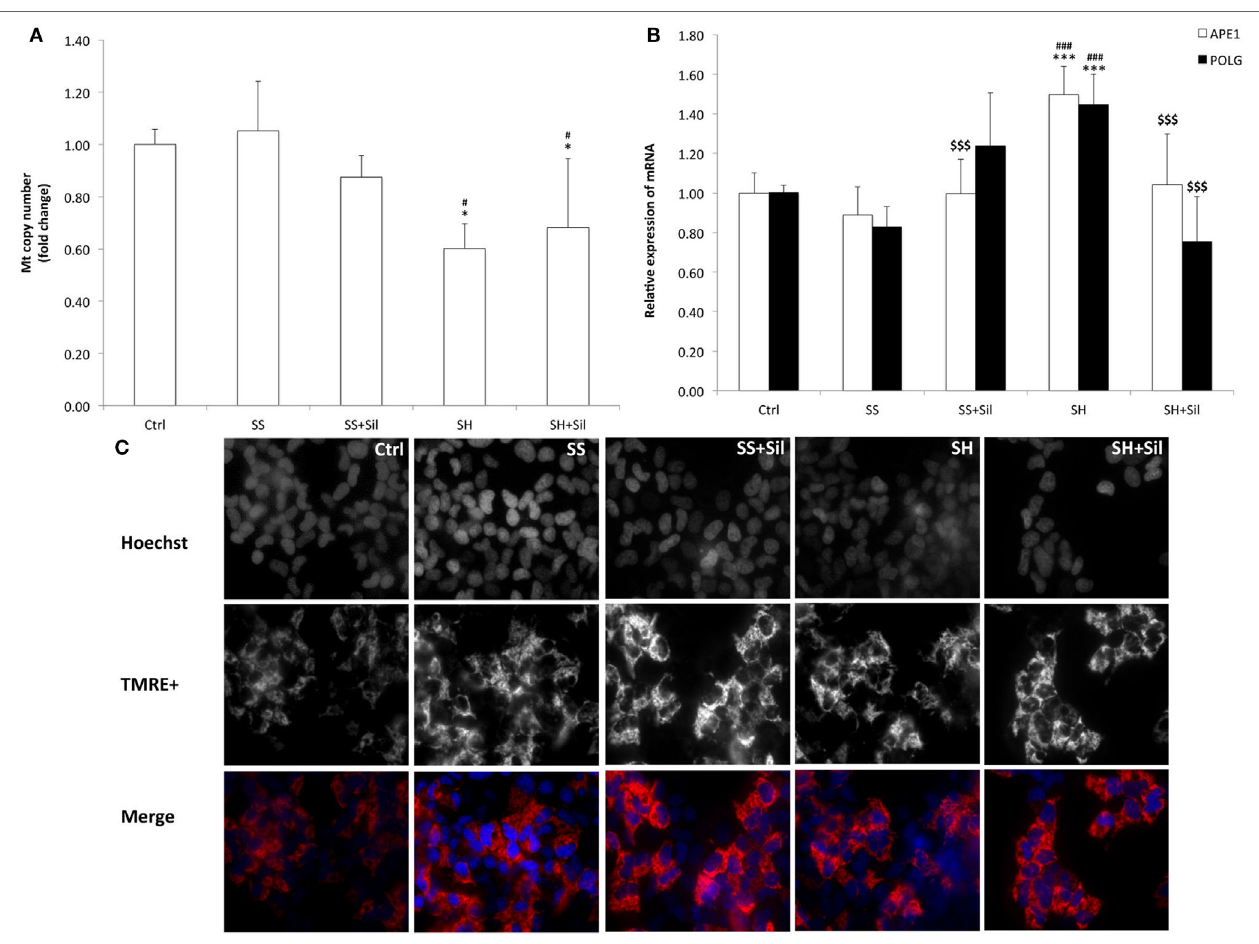
FigUre 5 | Effect of silybin on mitochondrial DNA (mtDNA) copy number and membrane polarization. Under the conditions of Figure 1 , the following parameters were measured: (a) mtDNA copy number by quantitative PCR (qPCR) using primer for COII. The nuclear gene β -actin was used as the internal control; data were expressed as fold induction with respect to controls. (b) The mRNA expression of APE1 and POLG genes related to mtDNA repair; β -actin was used as the internal control and data were expressed as fold induction with respect to controls. (c) The mitochondrial polarization through cell vital staining with TMRE (mitochondria, red fluorescence) and Hoechst33342 (nuclei, blue fluorescence). Representative images for all the experimental conditions are reported separately for each staining (black/white) and then merged in colors. Images were acquired using 40 × objective (scale bar 35 µm). Values are mean ± SD from at least three independent experiments. ANOVA followed by Tukey’s test was used to assess the statistical significance between groups. Significant differences are denoted by symbols: Ctrl vs all treatments *** p ≤ 0.001, * p ≤ 0.05; simple steatosis (SS) vs all treatments ### p ≤ 0.001, # p ≤ 0.05; steatohepatitis (SH) vs all treatments $$$ p ≤